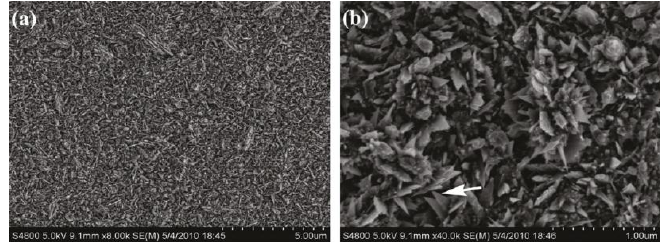
Figure 4. Low magnification ( a ) and high magnification ( b ) SEM images of a Ni film with nanosheet morphology formed by the constant voltage (CV) mode from an ionic electrolyte. Reprinted (adapted) with permission from [42]. Copyright 2011, American Chemical